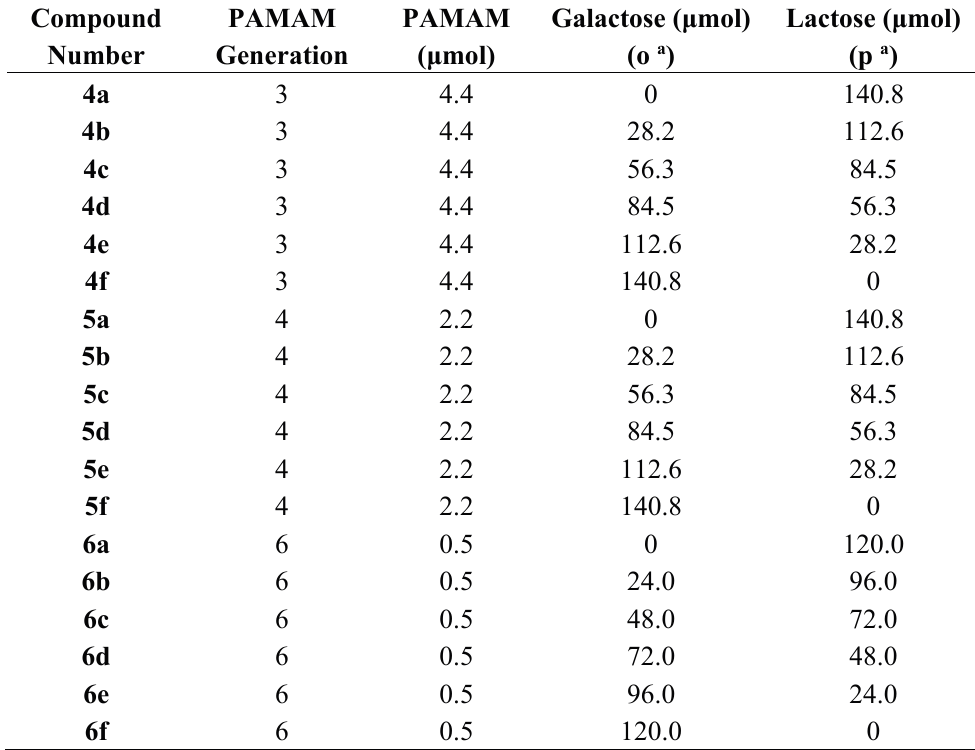
Table 4. Amounts used in synthesis of peracetylated pre-compounds 4a – 6f